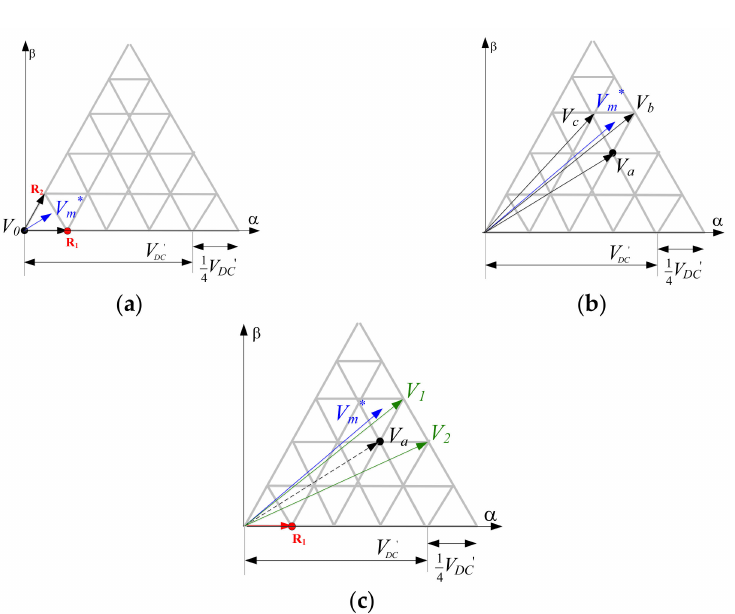
Figure 8. Five-level inverter (5LI) + TLI. ( a ) Space vector modulation (SVM) at a low modulation index. ( b ) SVM at a high modulation index. ( c ) Modified